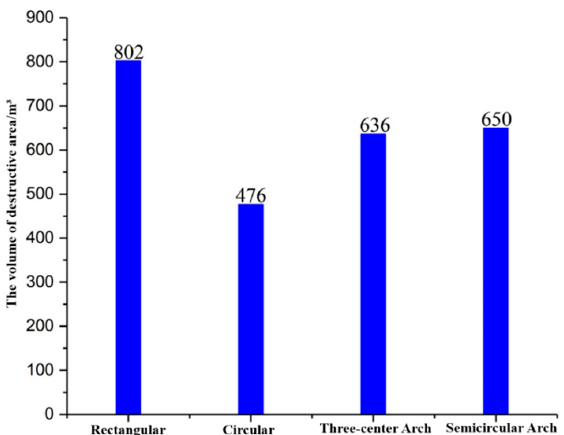
Figure 8. Influence of section shape on the scope of the damage zone of the rock surrounding a bottom drainage roadway.